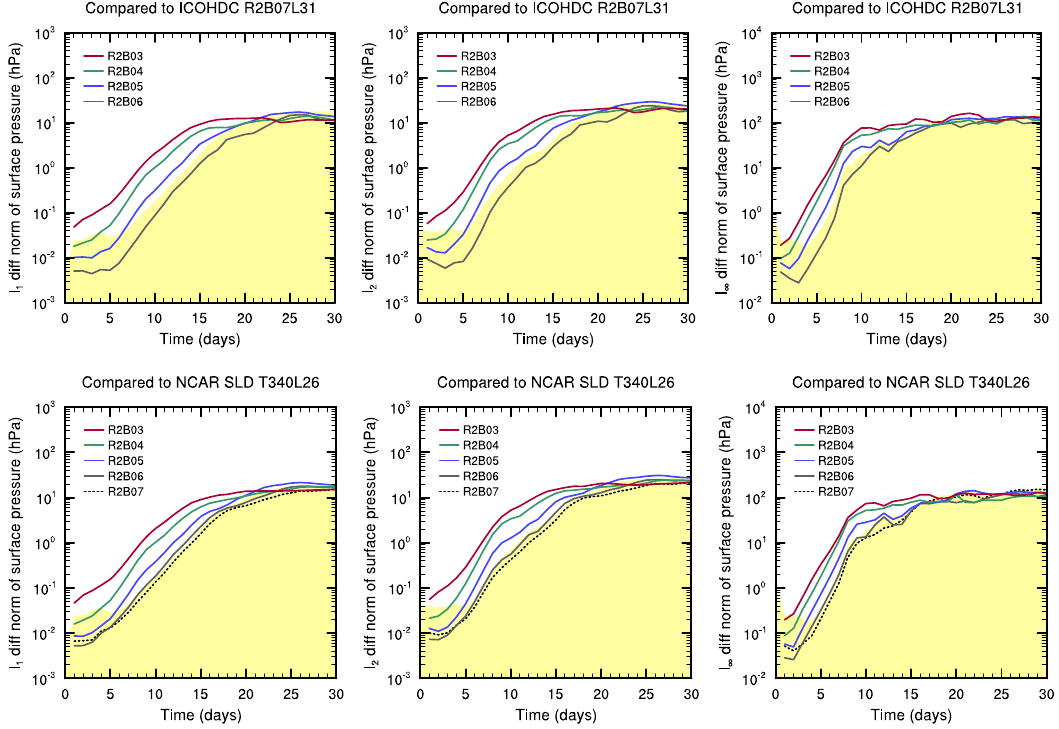
Fig. 8. l 1 , l 2 and l ∞ norms (left, middle and right columns, respectively) of surface pressure differences (unit: hPa) in the Jablonowski and Williamson (2006a,b) baroclinic wave test between lower-resolution ICOHDC simulations and the R2B7 solution (upper row), and between all ICOHDC simulations shown in Fig. 7 and the NCAR semi-Lagrangian model result at T340 resolution (lower row). Further details can be found in Sect.